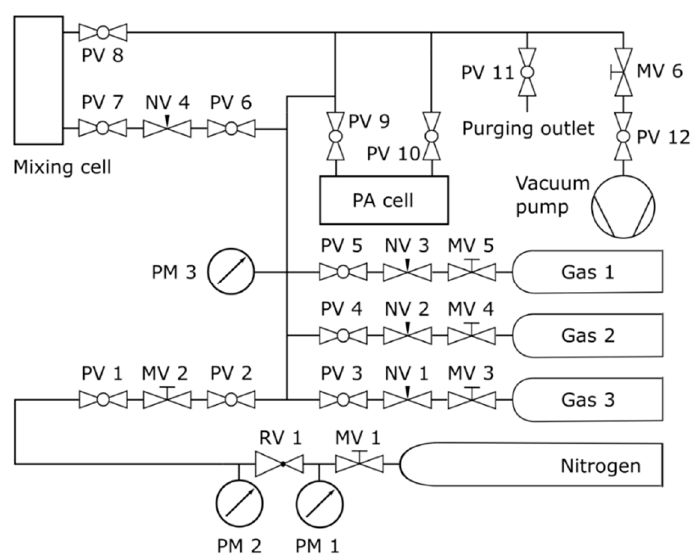
Figure 1. Experimental photoacoustic (PA) setup (block diagram).